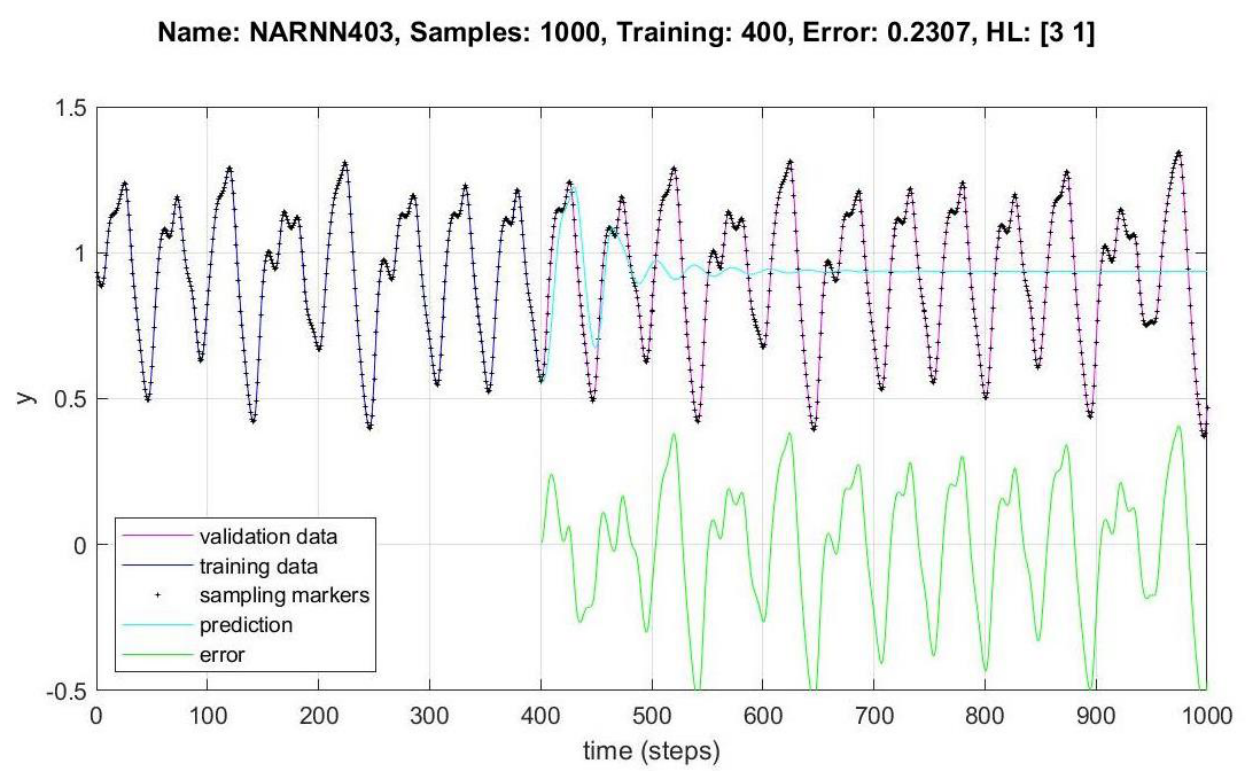
Figure 8. Performance of NARNN403 for 1000 samples